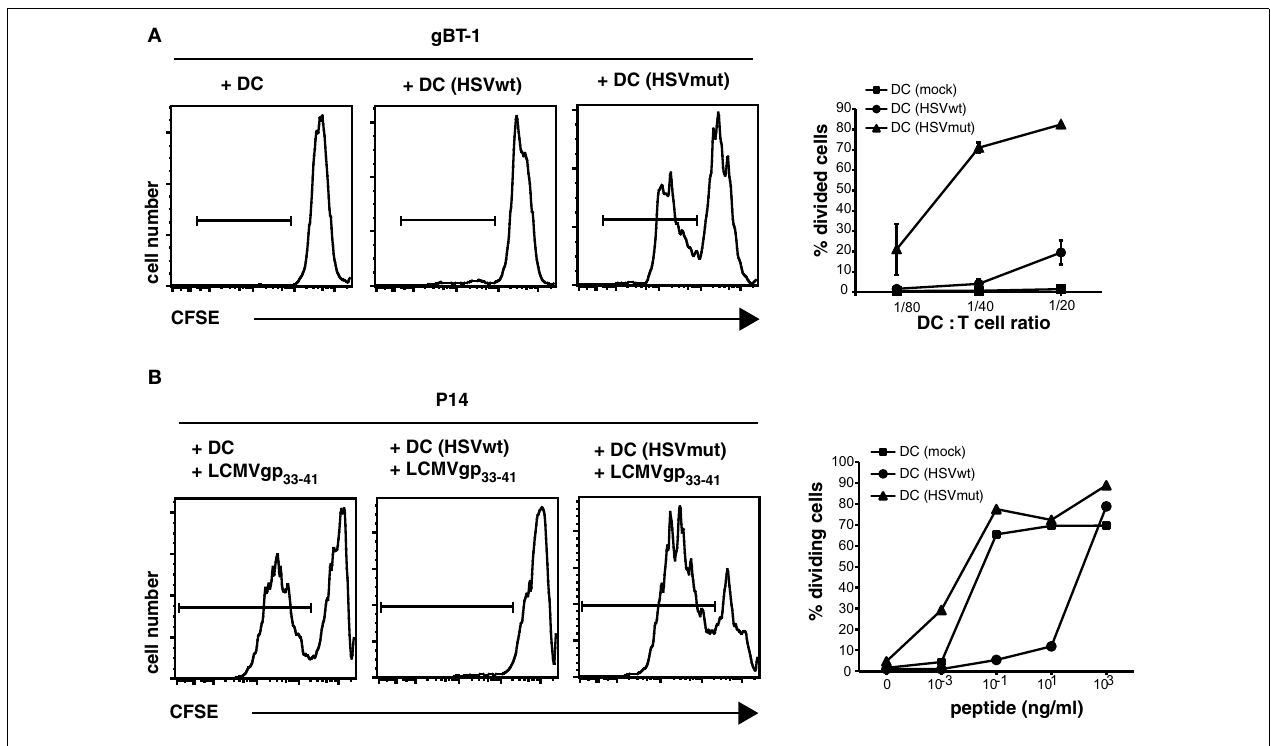
gp33-41-specific CD8 + P14T cells (B) . Appropriate conditions for DC: Tcell ratio and peptide concentration were determined by titration [ (A,B) side insets]. Main graphs show results of CFSE-profiles of gated CD8 + T cells for one experiment out of four with similar results in which 2500 DCs were cultured with 5 × 10 4 CFSE-labeledT cells for 4days and peptide concentration was